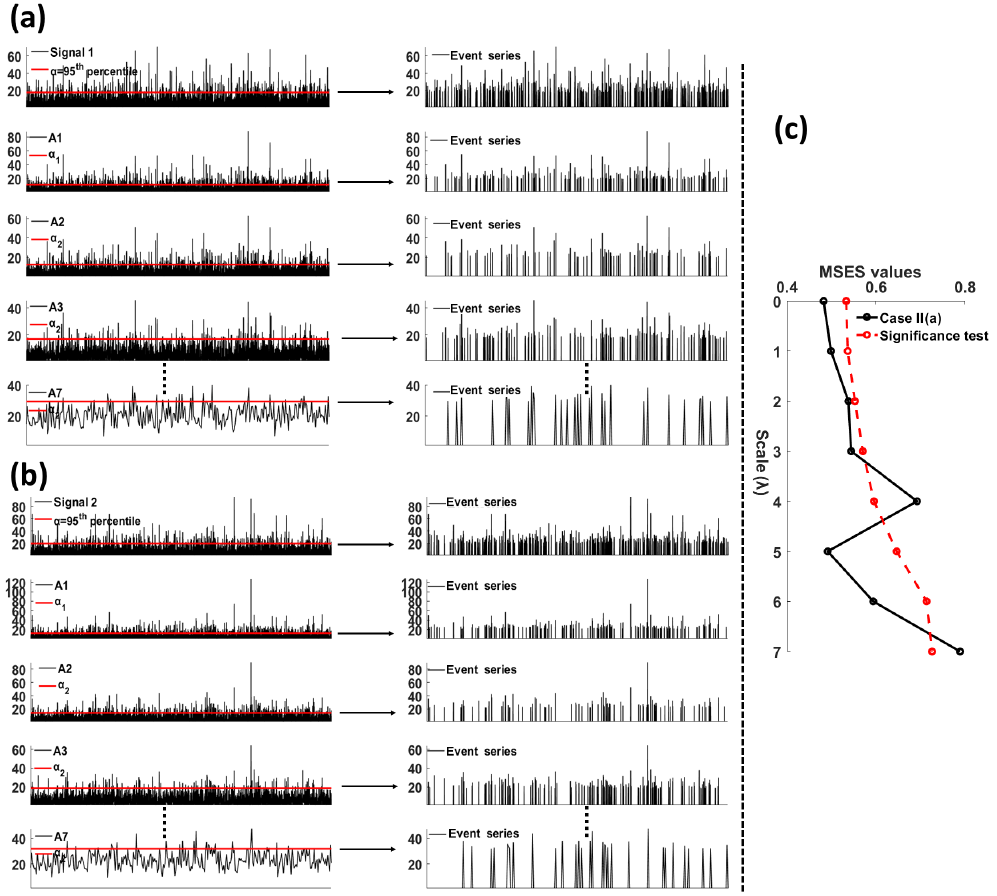
Figure 3. Multi-scale event synchronization (MSES) stepwise methodology. (a) Signal 1 and its decomposed component along with corre- sponding event series after applying the (95th percentile) threshold. (b) Same for signal 2. (c) Event synchronization values corresponding to each